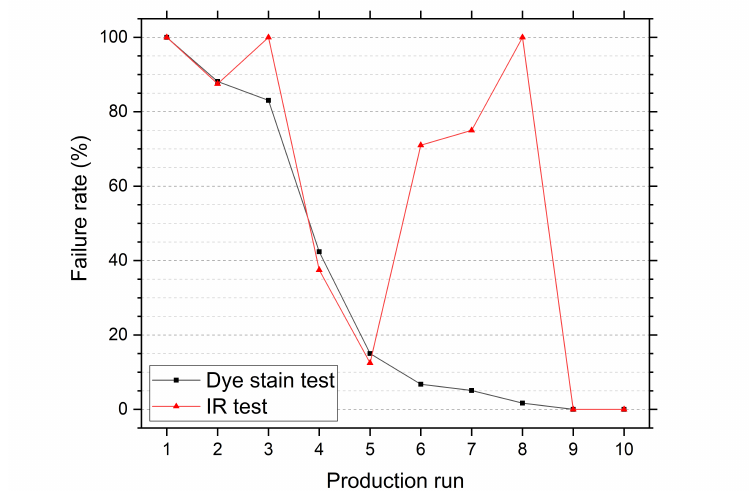
Figure 7. Failure rates measured using IR transmission and dye stain testing for 10 consignments of samples produced using different process settings, such as rotation mechanisms and coating